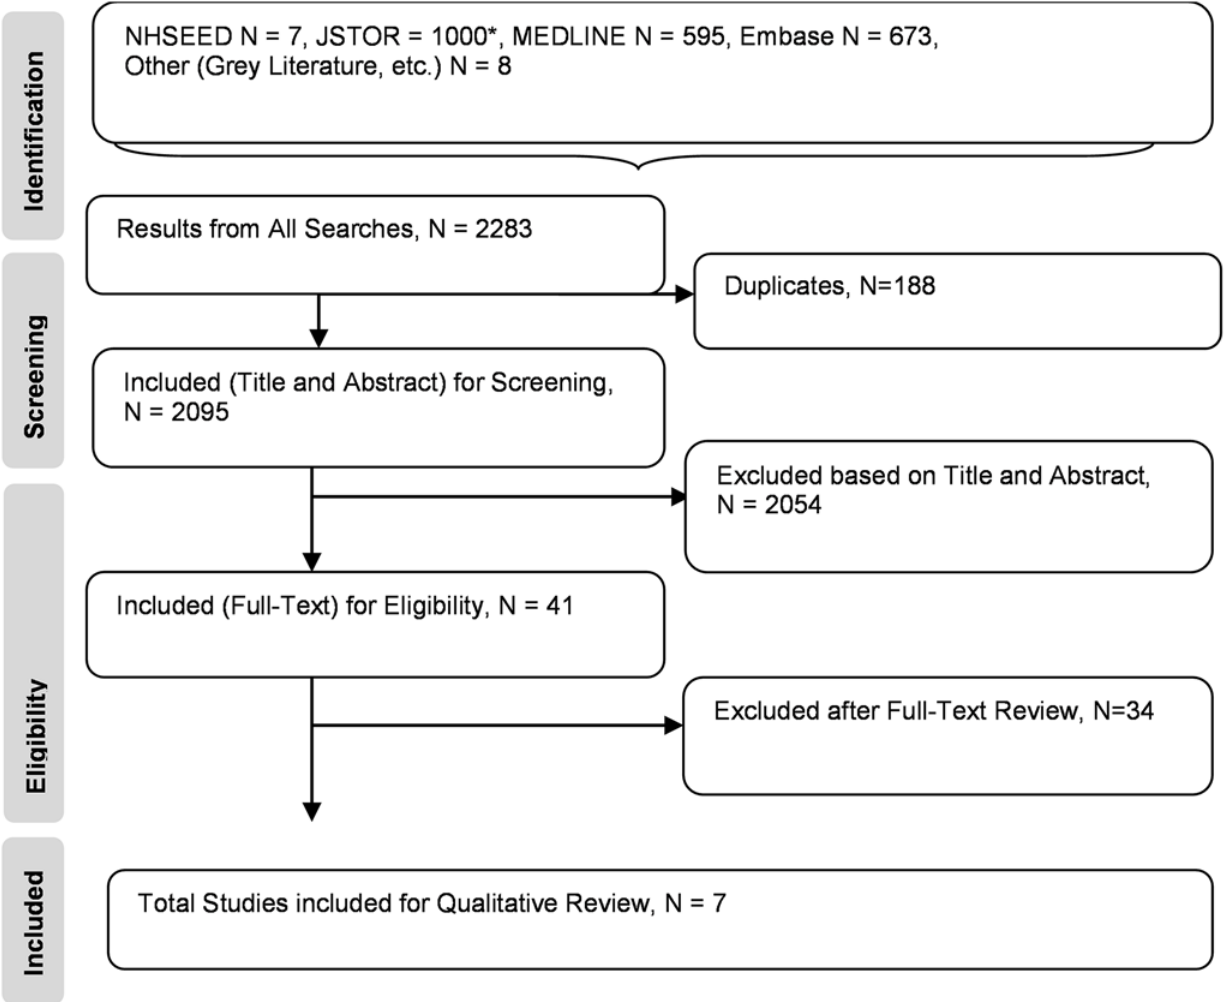
Fig 1. Preferred reporting items for systematic reviews and meta-analyses (PRISMA) diagram. JSTOR, Journal Storage; MEDLINE, Medical Literature Analysis and Retrieval System Online; NHSEED, National Health Service Economic Evaluation Database. 1000 * : Although 1,490 articles were found using JSTOR, only 1,000 articles were accessible due to limitations of the JSTOR